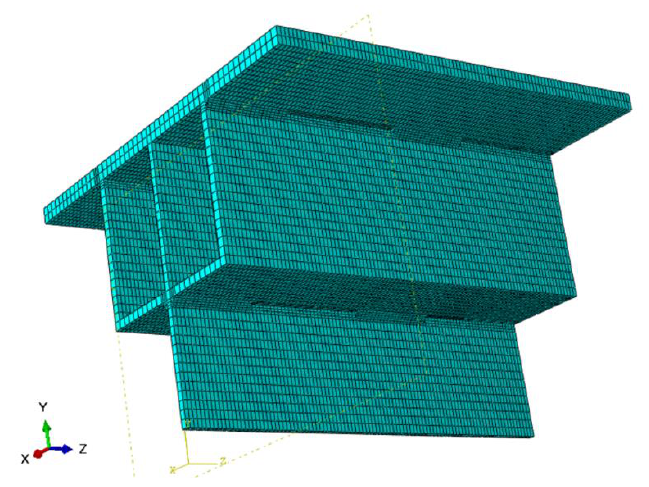
Figure 9. ABAQUS model of crane beam.